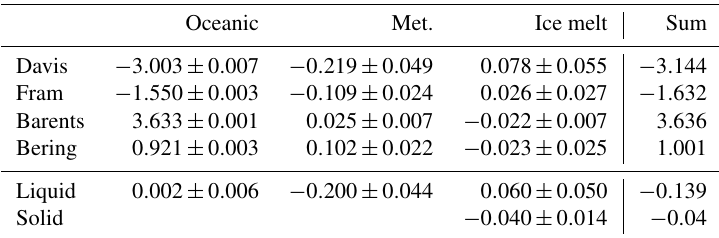
Table 10. Mean volume fluxes (Sv ± standard deviation) for a three-end-member model with seawater salinity and δ 18 O fixed at 35.0 and 0.35‰ respectively. Positive values indicate fluxes into the Arctic. Values of solid freshwater flux from Tsubouchi et al. (2012). Oceanic Met.